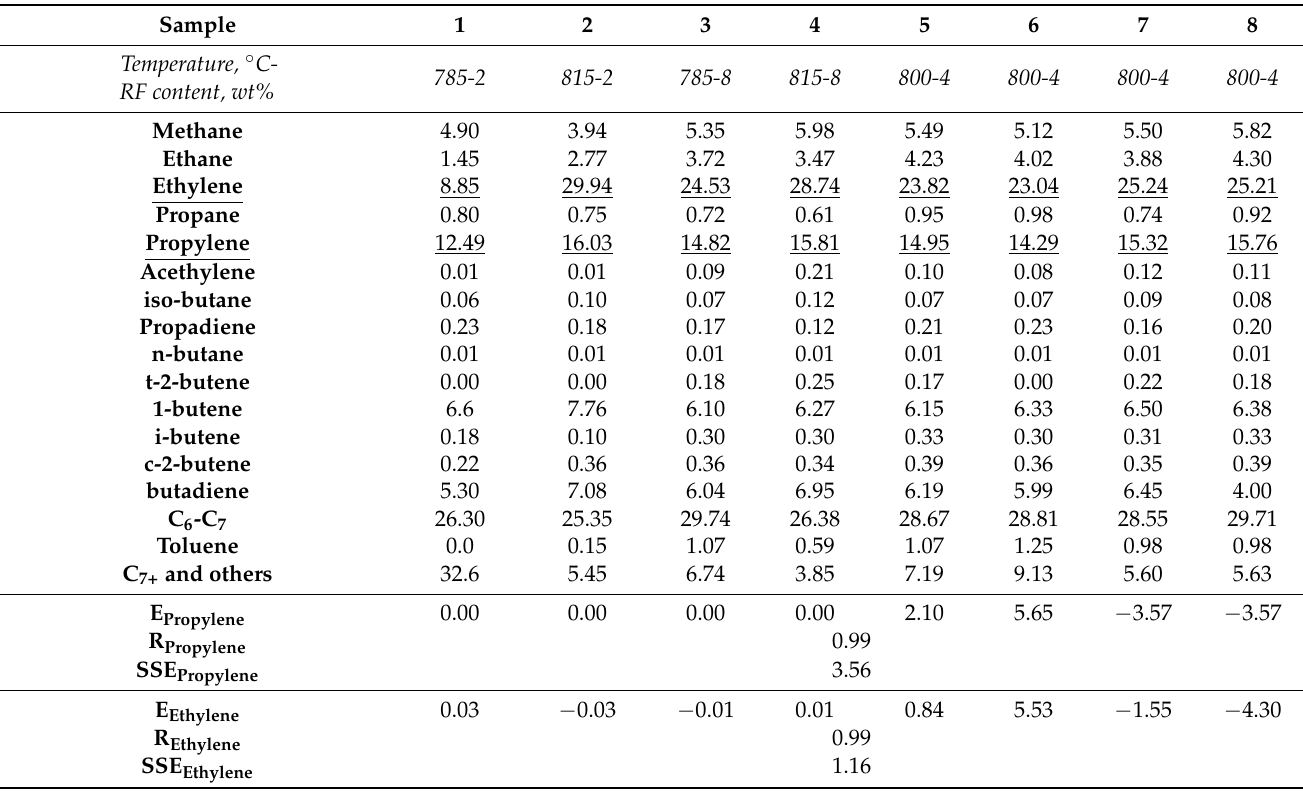
Table 5. The gas chromatography with flame ionization detector (GC-FID) results. Percent errors for ethylene and propylene contents in the product (E ethylene and E Propylene , respectively). Correlation coefficient for ethylene and propylene contents (R Ethylene and R Propylene , respectively). Sum of squares of the experimental deviations (SSE Ethylene and SSE Propylene